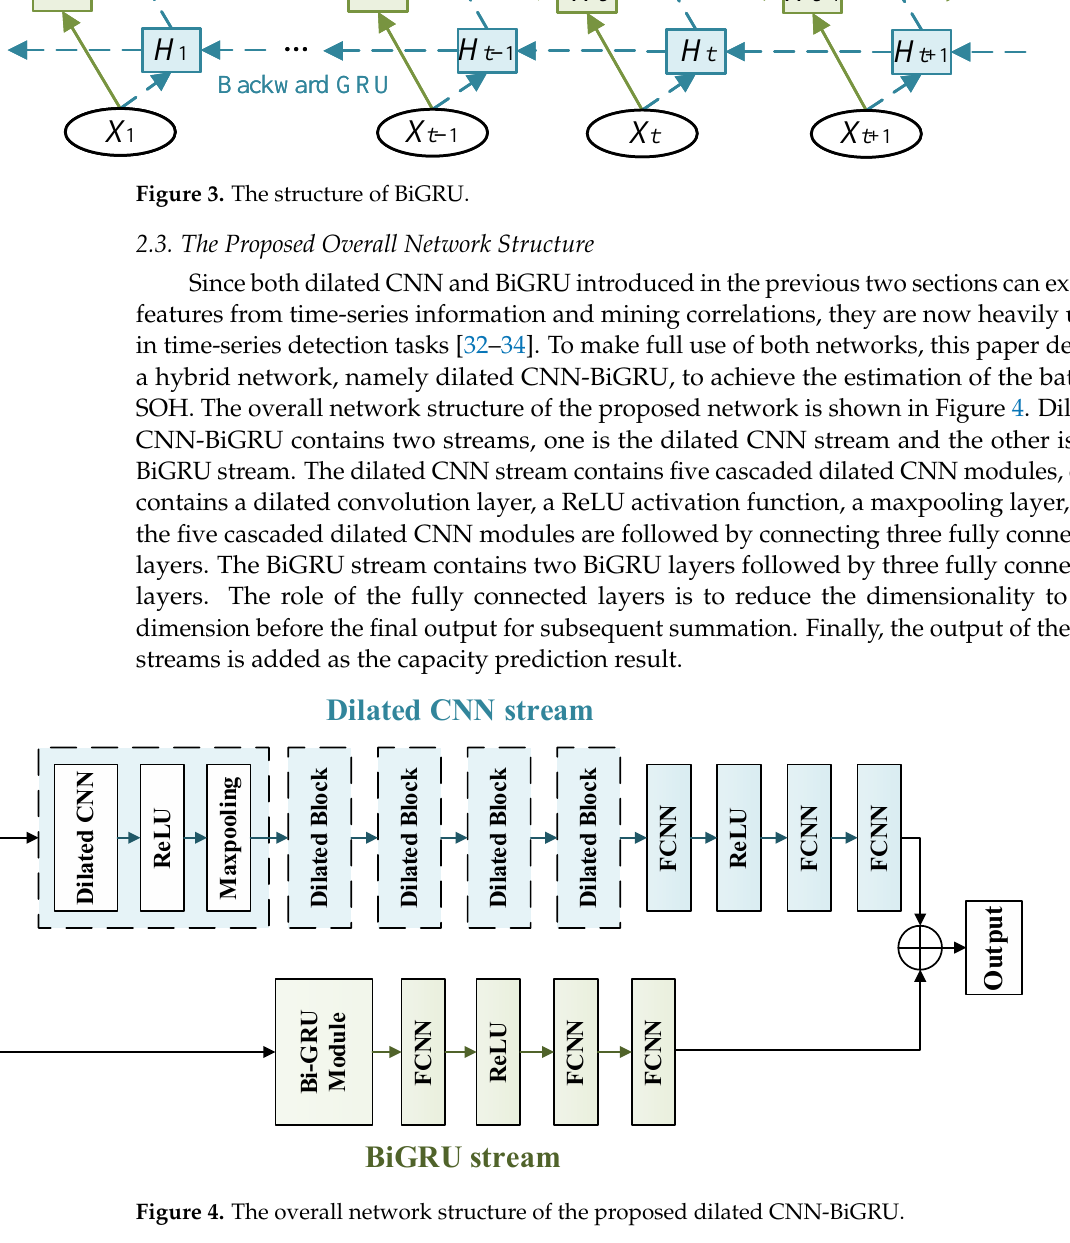
E po c h s Figure 5. MAE under different hyperparameters: neurons and epoch. Table 1. Specifications of the DCNN-BiGRU architecture. Layer Input [N, M]